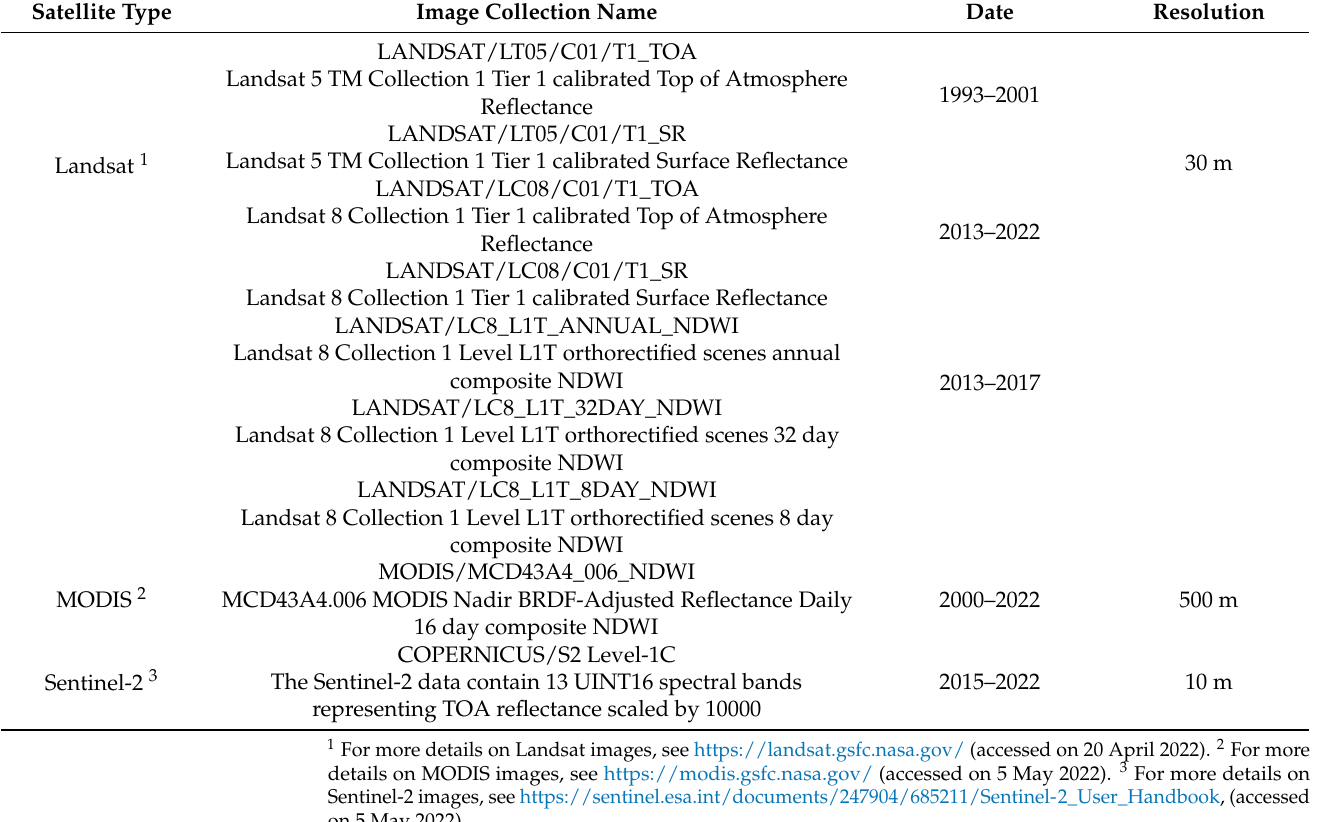
Table 1. List of Landsat, MODIS, and Sentinel-2 image data used in this study.